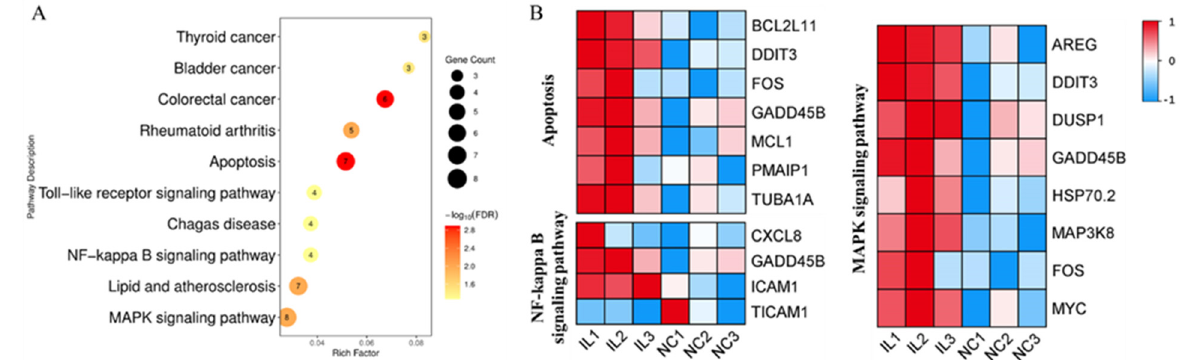
Figure 3. Transcriptome sequencing of SCNT-IL17D (IL) and SCNT-NC (NC) embryos at 4-cell stage. ( A ) Comparison of the percentage of embryos developing to 4-cell stage between SCNT- IL17D and SCNT-NC groups. ( B ) Principal component analysis (PCA) plot for six samples from IL and NC groups at 4-cell stage. Each sample was a mixture of 20 to 30 embryos. ( C ) Violin plot of mRNA levels of 6296 transcriptome sequencing-detected genes (with the sum of individual gene’s FPKM value >1) of IL and NC embryos at 4-cell stage. ( D ) Bar plot of differentially expressed genes (IL vs. NC) between IL and NC groups at 4-cell stage. ( E ) Transcriptome sequencing-detected mRNA expression levels of eight randomly selected genes in NC and IL group. ( F ) qRT-PCR -meas- ured relative mRNA expression levels of the same eight genes in SCNT-NC and SCNT-IL17D em- bryos at 4-cell stage. Data were obtained from three independent replicates. Values were presented as mean ± SEM. * and ** means p < 0.05 and p < 0.01, respectively.